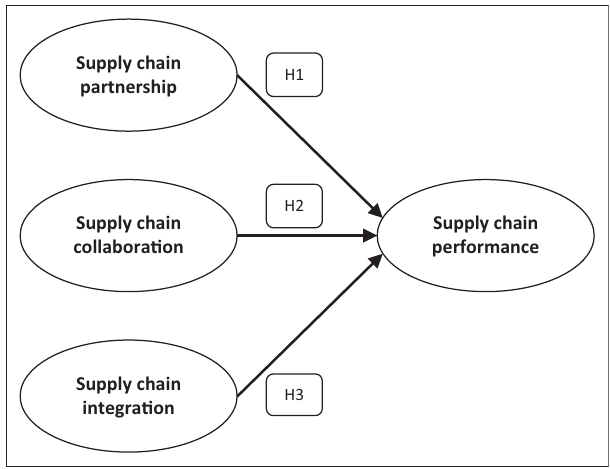
FIG URE 1: Conceptual